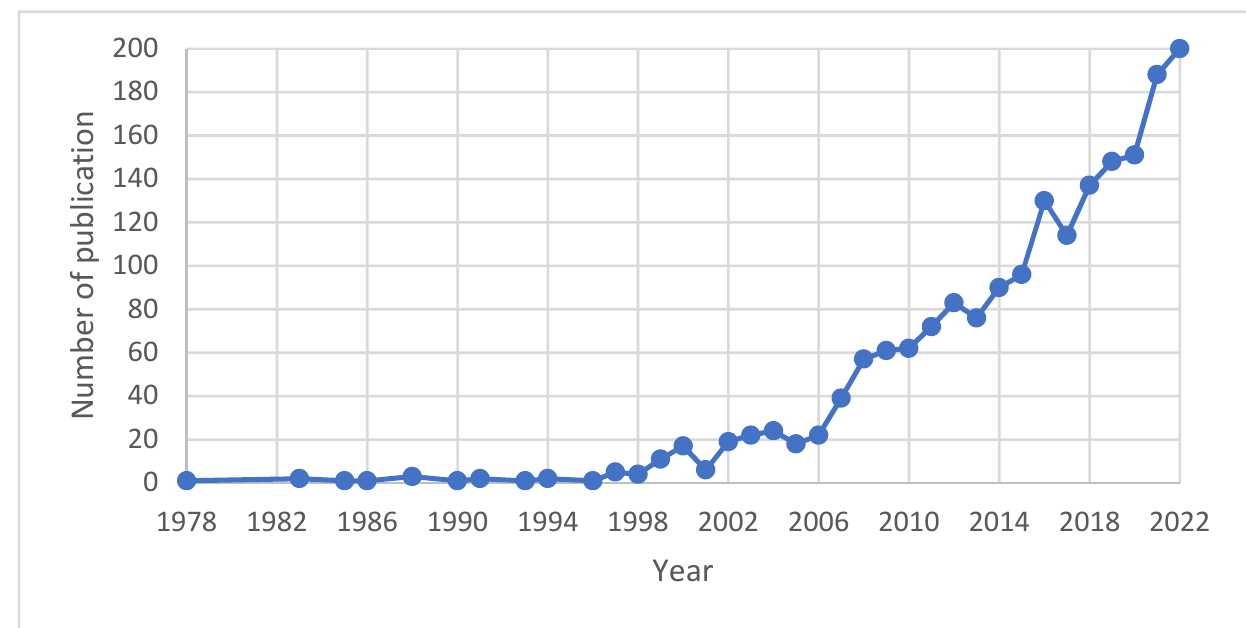
Figure 2. Publication trend of laccase research on pollutant or wastewater.